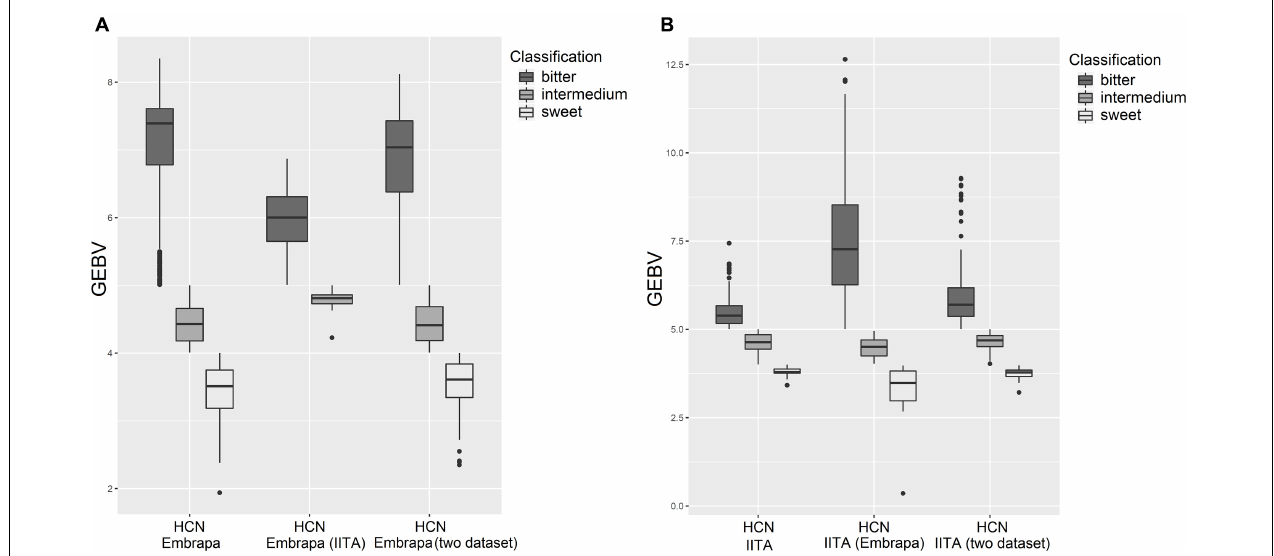
FIGURE 3 | Boxplots contrasting the hydrogen cyanide predictions on country-dataset and cross-country-dataset to show sweet, intermedium and bitter classes. (A) Hydrogen cyanide for Embrapa’s clones based on GEBV prediction on Embrapa’s dataset, IITA’s dataset and the two datasets together, respectively. (B) Hydrogen cyanide for IITA’s clones based on GEBV prediction on IITA’s dataset, Embrapa’s datasets and the two datasets together,